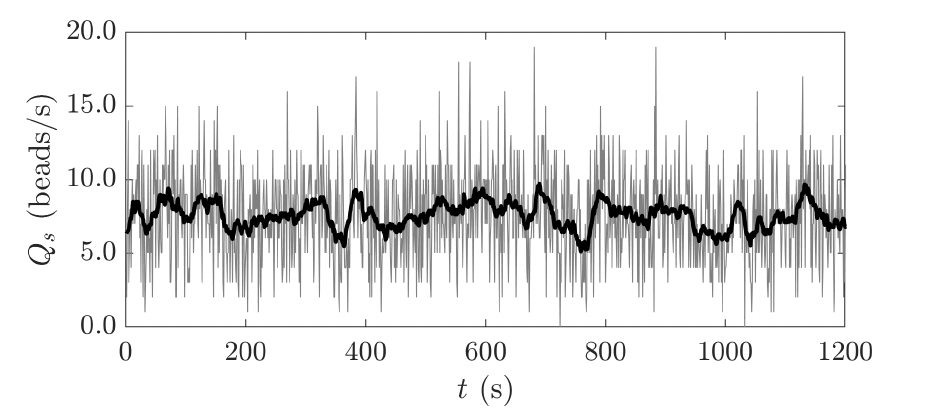
Figure 4. Sediment discharge time series measured during test T2 at the channel centerline with the bedload discharge meter described in Mendes et al. [44].